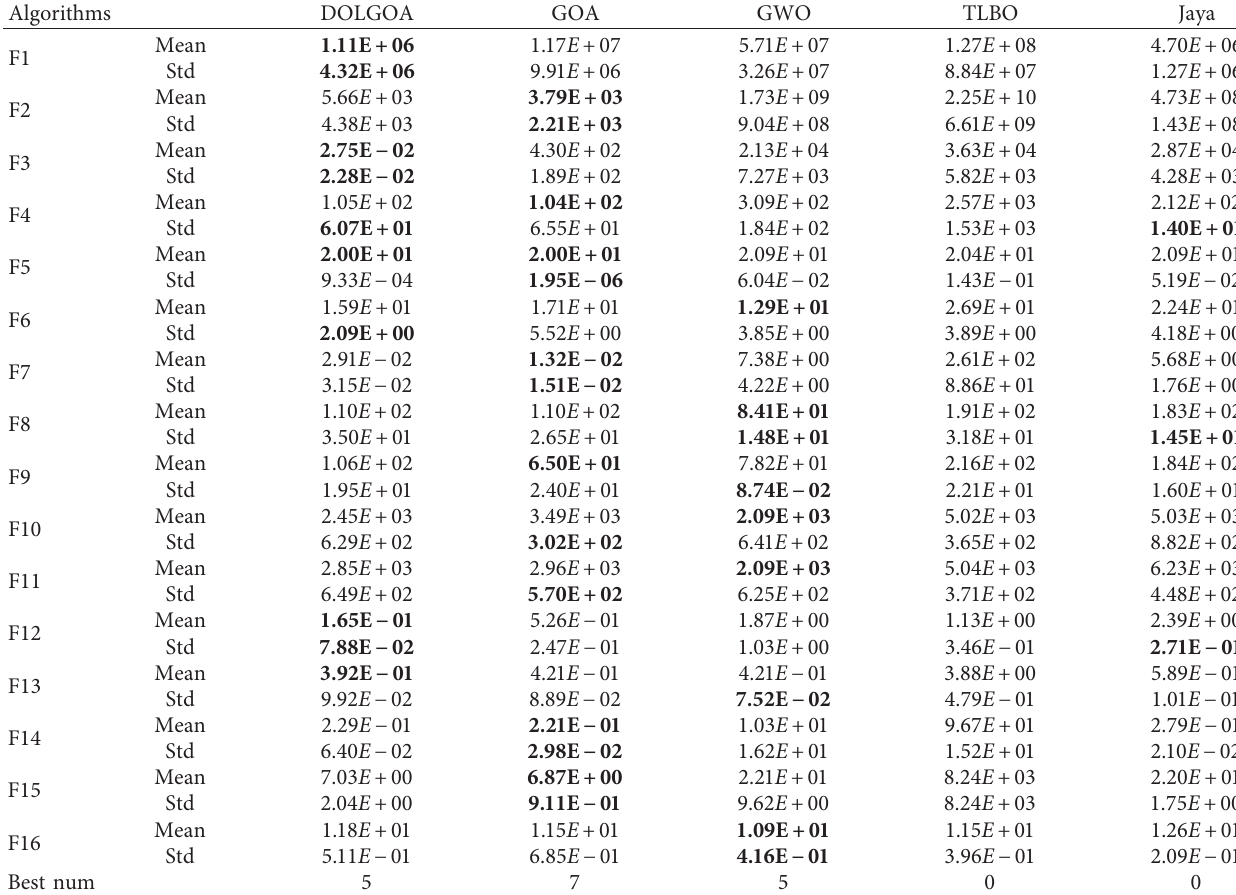
Table 4: The mean and standard value of unimodal/multimodal test functions. Algorithms